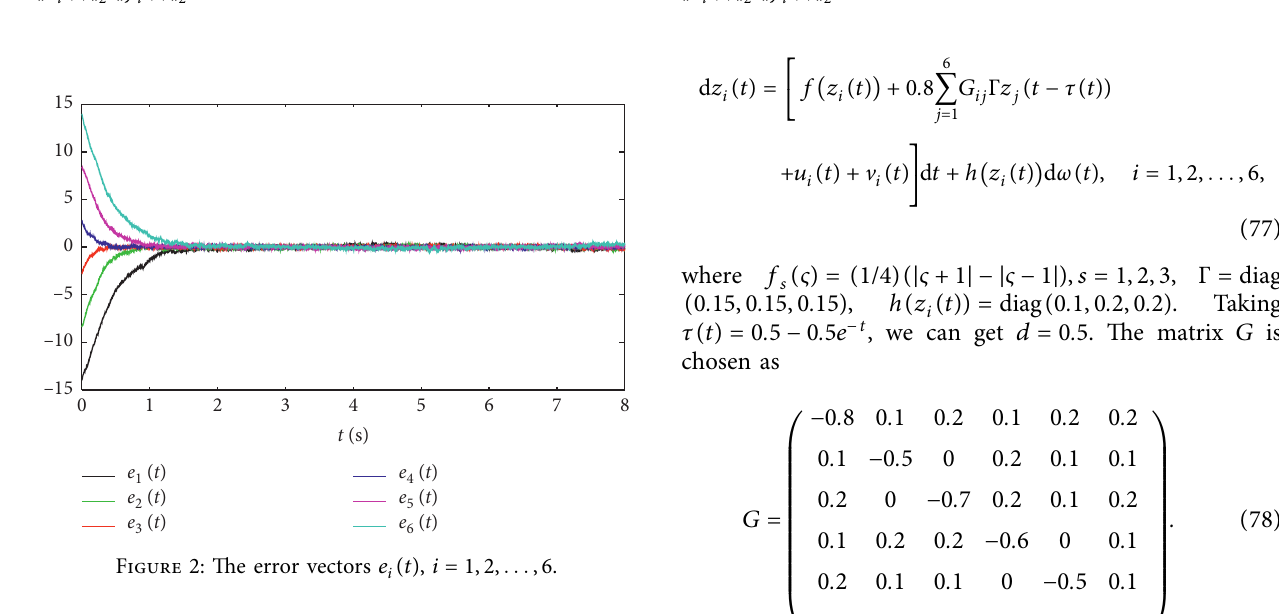
Figure 1: The norms of the input and output vectors ‖ u